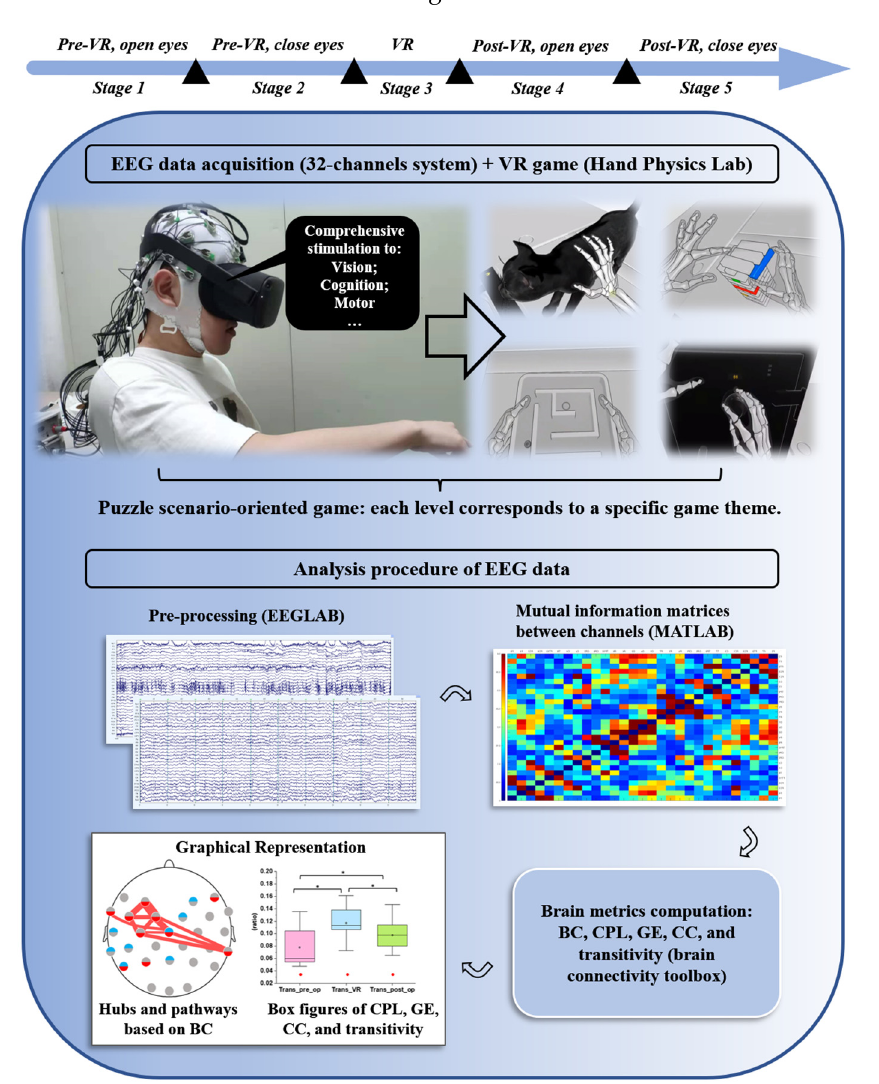
Figure 1. Depiction of this experiment: the sequence of the participants’ different stages and the procedures of acquiring and analyzing EEG data.